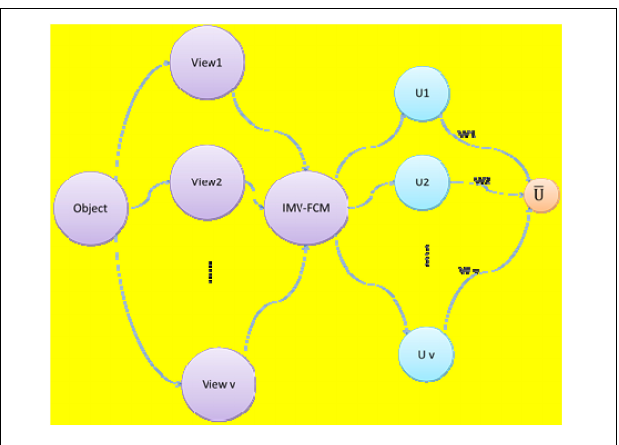
FIGURE 5 | Schematic diagram of IMV-FCM